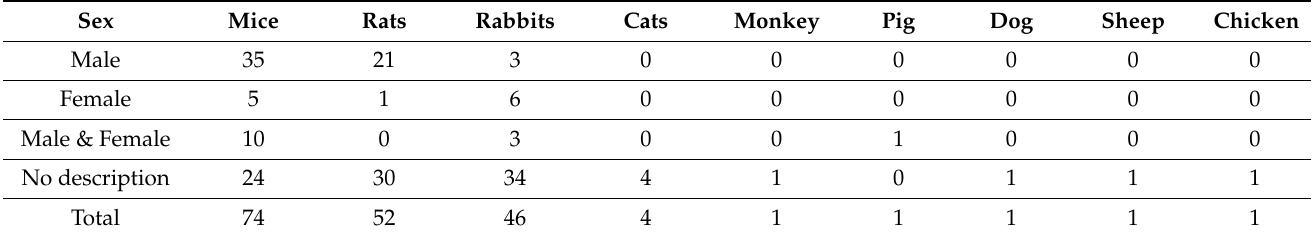
Table 1. A total number of animal studies with NaIO 3 grouped by sex of animals. Literatures were searched in the PubMed using the key words “sodium iodate, retinal pigment epithelium”